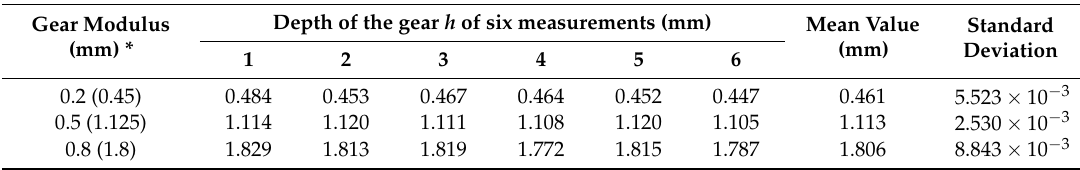
Table 2. Uncertainty of the measurement of different modulus gears.